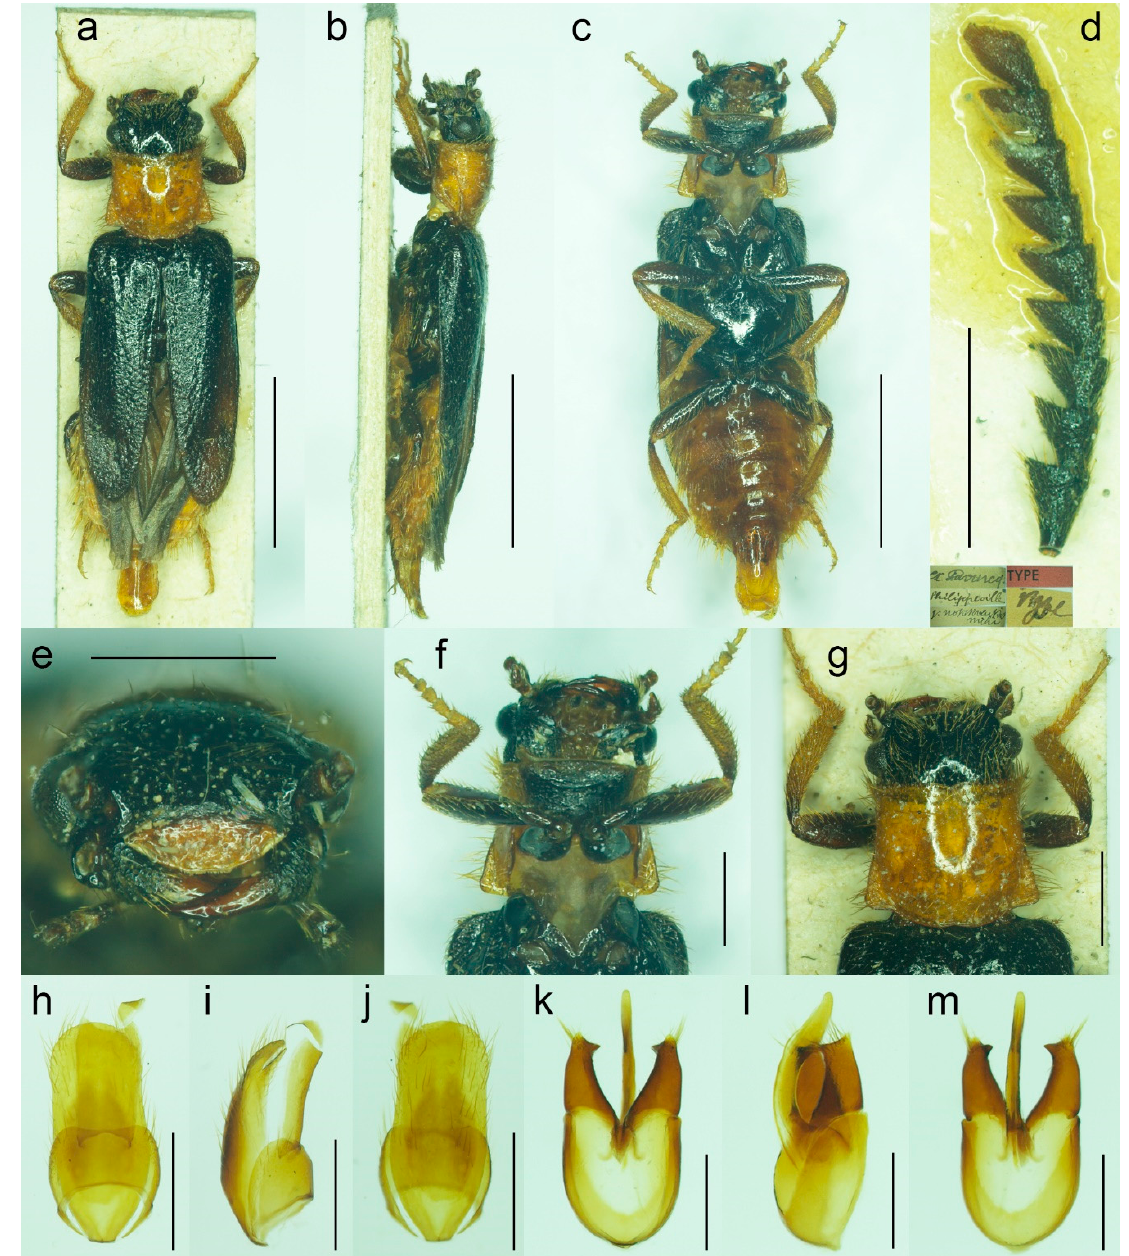
Figure 16. Malacogaster passerinii Bassi, 1834. Male holotype of Malacogaster notativentris Pic, 1949, syn. nov. ( a ) Habitus, dorsal view; ( b ) habitus, lateral view; ( c ) habitus, ventral view; ( d ) right antenna; ( e ) head, frontal view; ( f ) head and prothorax, ventral view; ( g ) pronotum, dorsal view; ( h ) genital capsule formed by tergites IX and X, and sternite IX, dorsal view; ( i ) genital capsule formed by tergites IX and X, and sternite IX, lateral view; ( j ) genital capsule formed by tergites IX and X, and sternite IX, ventral view; ( k ) aedeagus, dorsal view; ( l ) aedeagus, lateral view; ( m ) aedeagus, ventral view. Scale bars = ( a – c ) 3.0 mm; ( d – j ) 1.0 mm; ( k – m ) 0.5 mm.